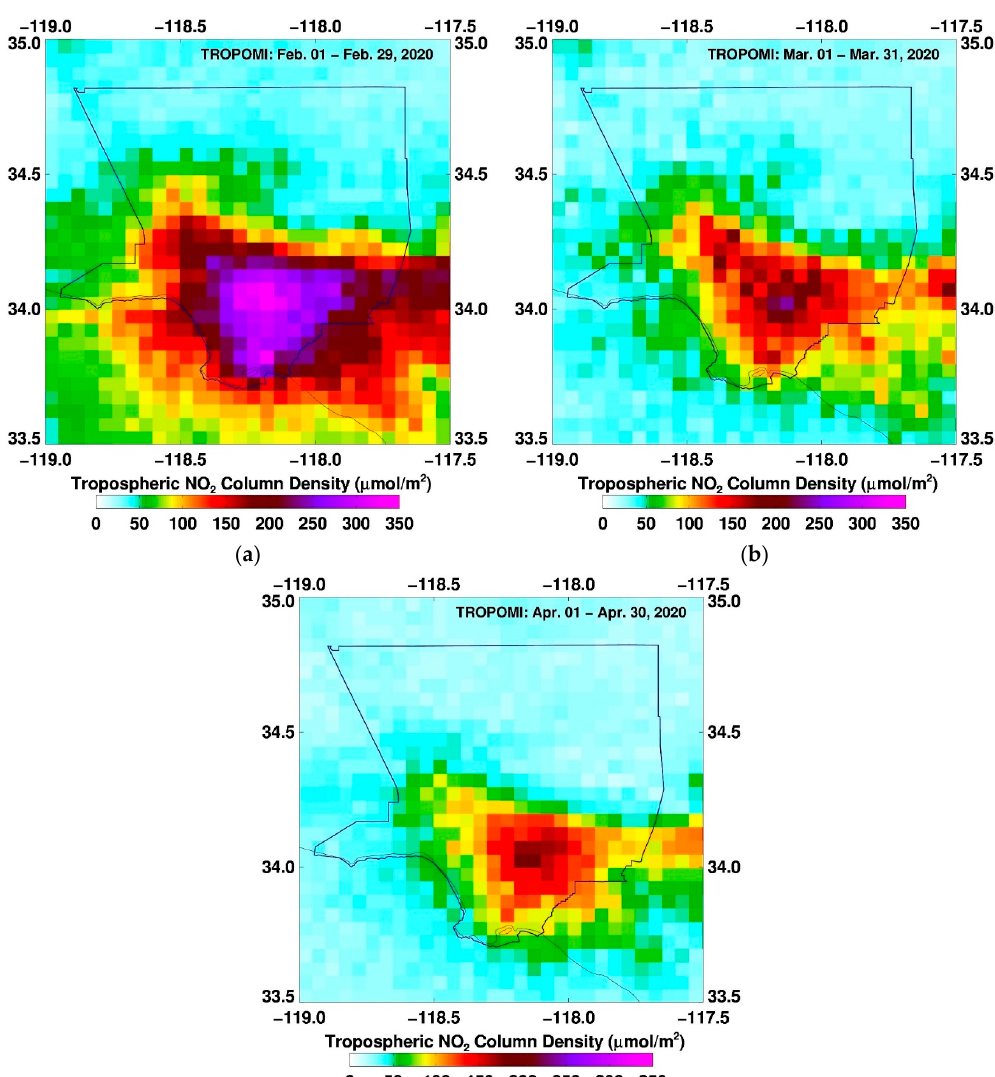
seen from Figure 12, February and March exhibited a wider range of mobility compared Figure 11. Distribution of NO 2 concentrations in Los Angeles, CA during February ( a ), March ( b ), and April ( c ). to April. The curve shifted to the left with high concentrations (tails of the curves), nearly 50% lower than the values observed in February and May. More than half of the signal was due to the lockdown, with only the highest concen- trations of NO 2 (due to industrial activity) remaining near the LA Port region, where most of the refinery and industrial capability in Los Angeles is located, as well as the Inland Empire (San Bernardino Valley), which is a major shipping hub. A recent study [44] showed that while total NO 2 reduction in Los Angeles during 15 March 15 to 30 April 2020 compared to the same time period in 2019 (Business as Usual, BAU) was about 66%, NO 2 reduction due to the lockdown measures was 35% and with the remaining 31% being due to the fact of seasonality. Even during the lockdown, it would be expected that there would be some industrial activity to support essential services. The trend in NO 2 is corre- lated to the mobility pattern observed during the lockdown. In Figure 12, the left image (a) is a histogram of the total column NO 2 for February, March, and April 2020, and the right image (b) is the distribution of distance a given cellphone travelled during the day- time period (i.e., when most movement occurs) for each corresponding month. As can be